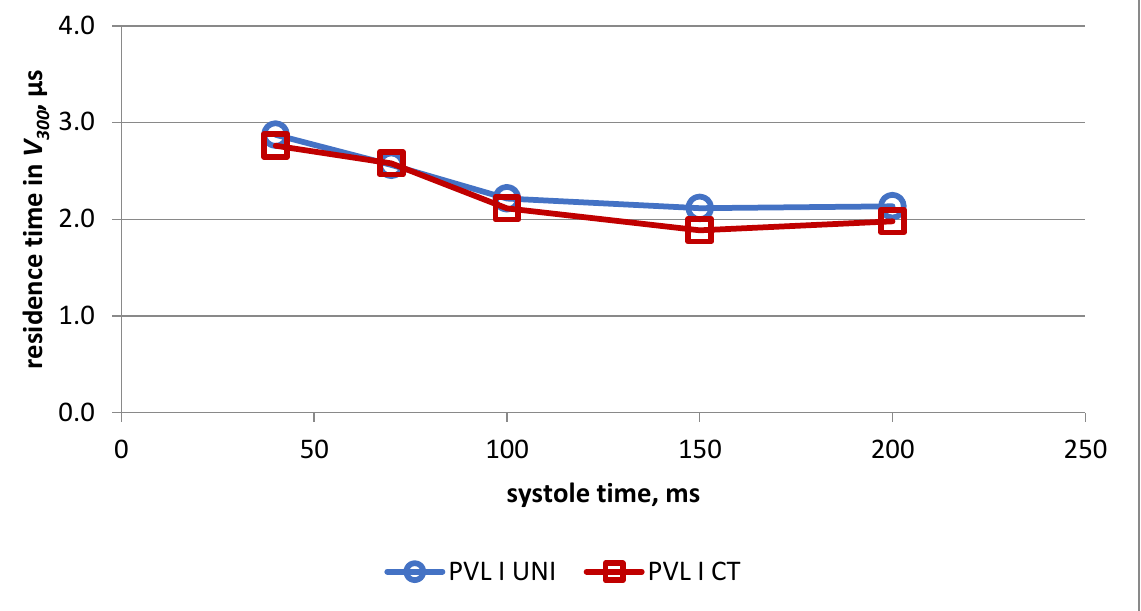
Figure 7. Duration of exposure to shear stress > 300 Pa in universal model (UNI) and real-life model (CT) for PVL model I.